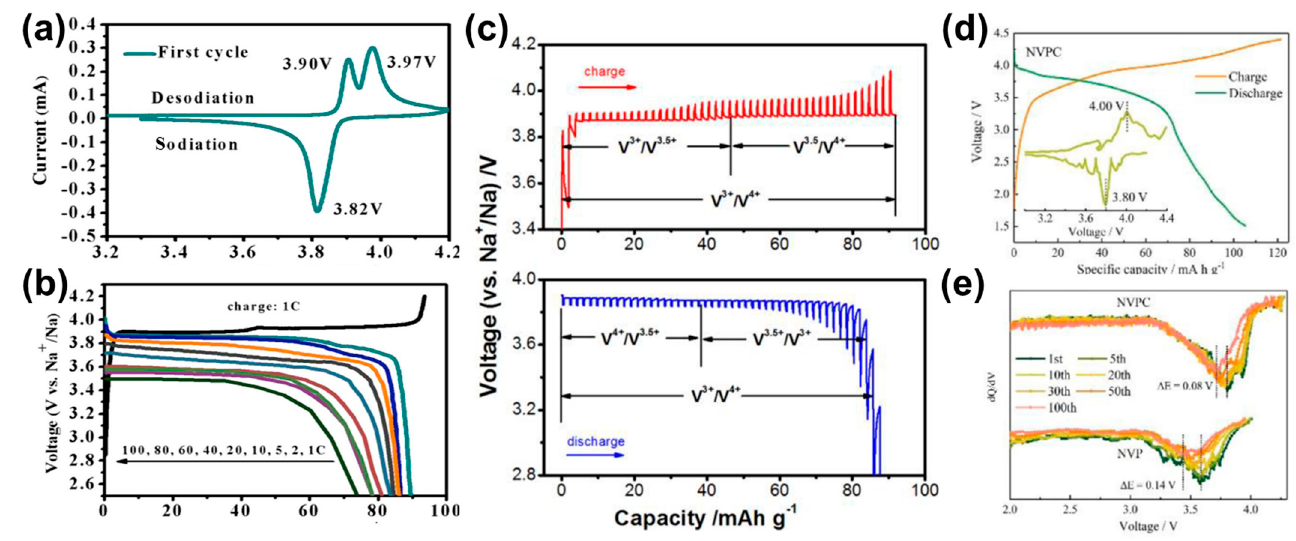
Figure 7. ( a ) CV curve at a scan rate of 0.1 mV s − 1 in 3.3–4.2 V and ( b ) the charge/discharge curves at various rates of the Na 7 V 4 (P 2 O 7 ) 4 (PO 4 )/C-GA cathode [46]. ( c ) The GITT charge and discharge curves of a Na 7 V 4 (P 2 O 7 ) 4 (PO 4 ) nanorod [115]. ( d ) Galvanostatic charge/discharge curves and the corre- sponding dQ/dV patterns of Na 2 (VO) 2 (HPO 4 ) 2 (C 2 O 4 ). ( e ) The dQ/dV plots of different cycles of Na 2 (VO) 2 (HPO 4 ) 2 (C 2 O 4 ) and Na 3 V 2 (PO 4 ) 3 at 0.2 C